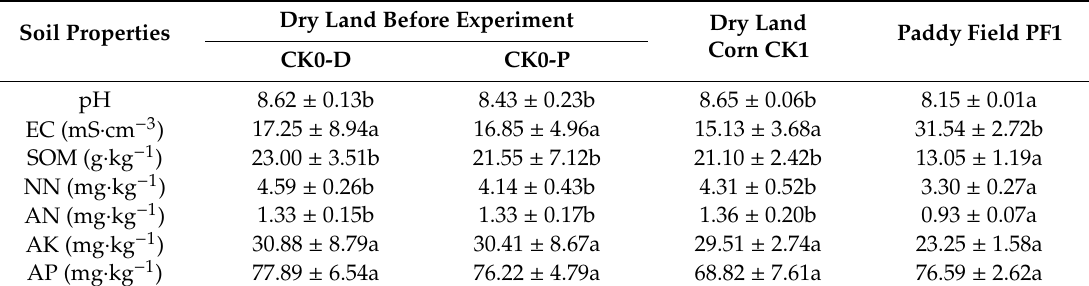
Table 1. Description of soil physicochemical properties before and after the conversion of dryland to